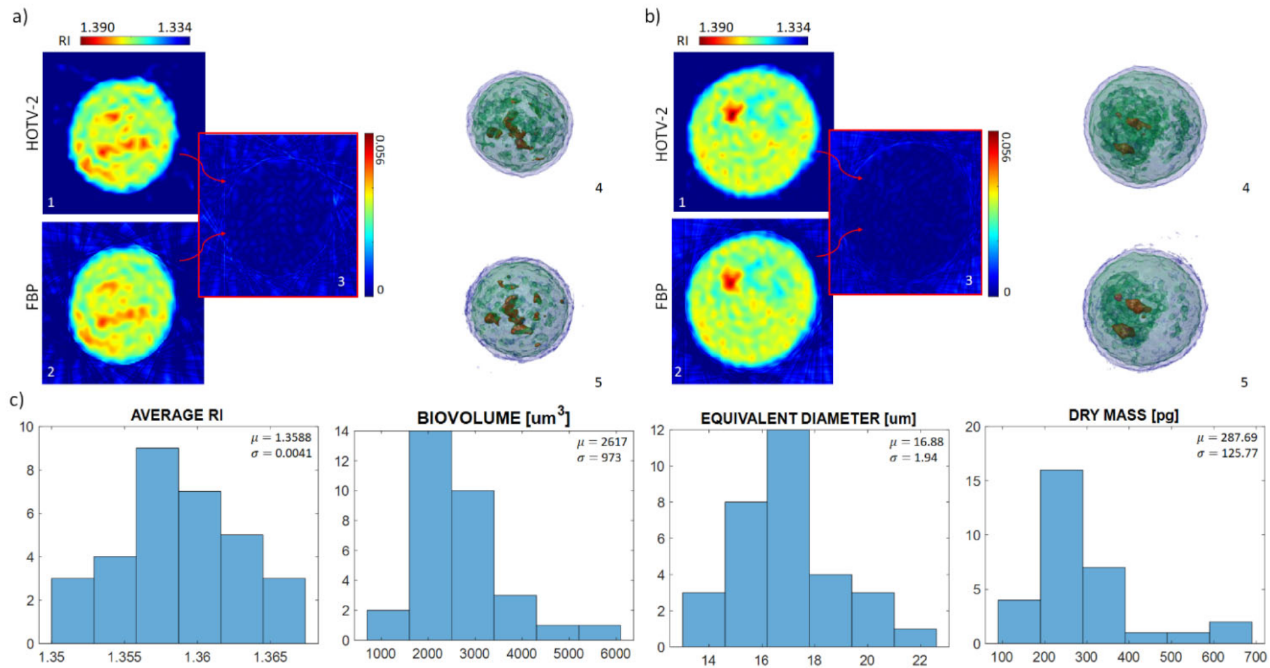
Figure 6. Tomograms of two NIH-3T3 cells. For both panels ( a , b ), cross-section slices from the HOTV-2 tomographic reconstruction (subfigures a1 , b1 ), cross-section slices from the FBP tomo- graphic reconstruction (subfigures a2 , b2 ), and the absolute value of the difference between the two cross-section slices (subfigures a3 , b3 ) are presented, together with isolevel visualizations for the HOTV-2 (subfigures a4 , b4 ) and FBP reconstructions (subfigures a5 , b5 ). ( c ) Histograms of aver- age refractive index, biovolume, equivalent diameter, and dry mass, computed over the NIH-3T3 under